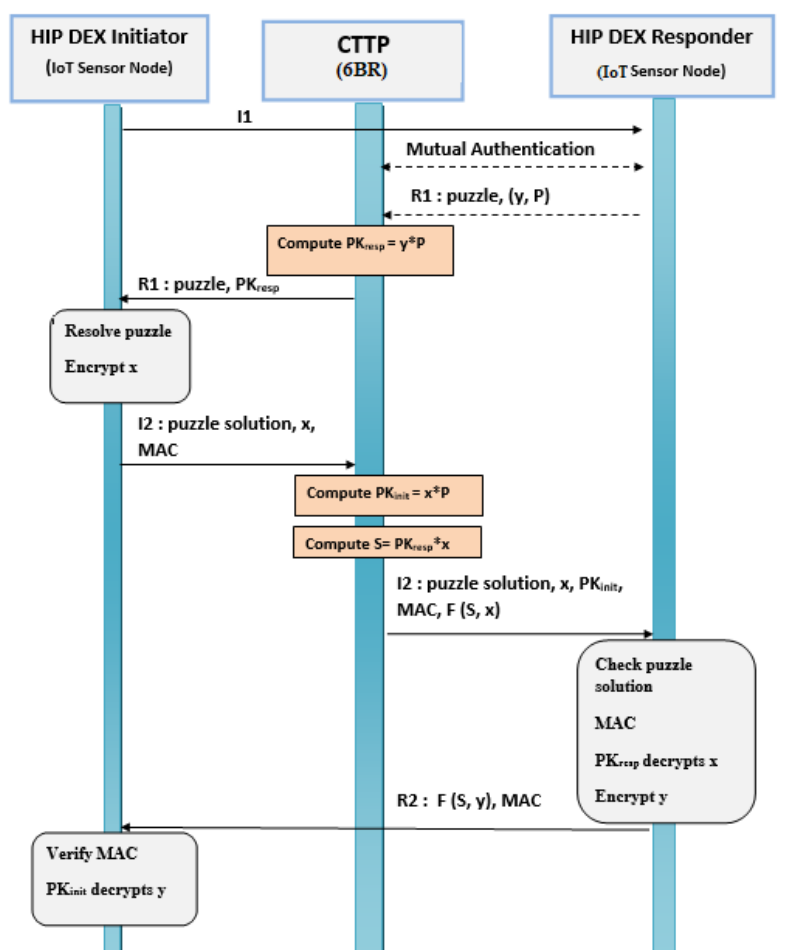
Figure 7. Proposed HIP DEX Secure Lightweight Association Establishment